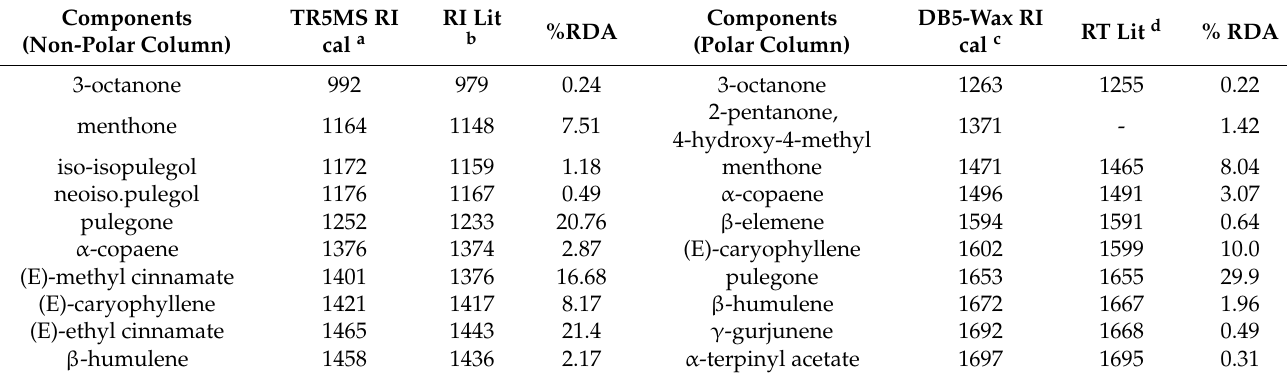
Table 1. Chemical composition of the essential oil of Clinopodium brownie , using two chromatographic systems, with the polar and non-polar